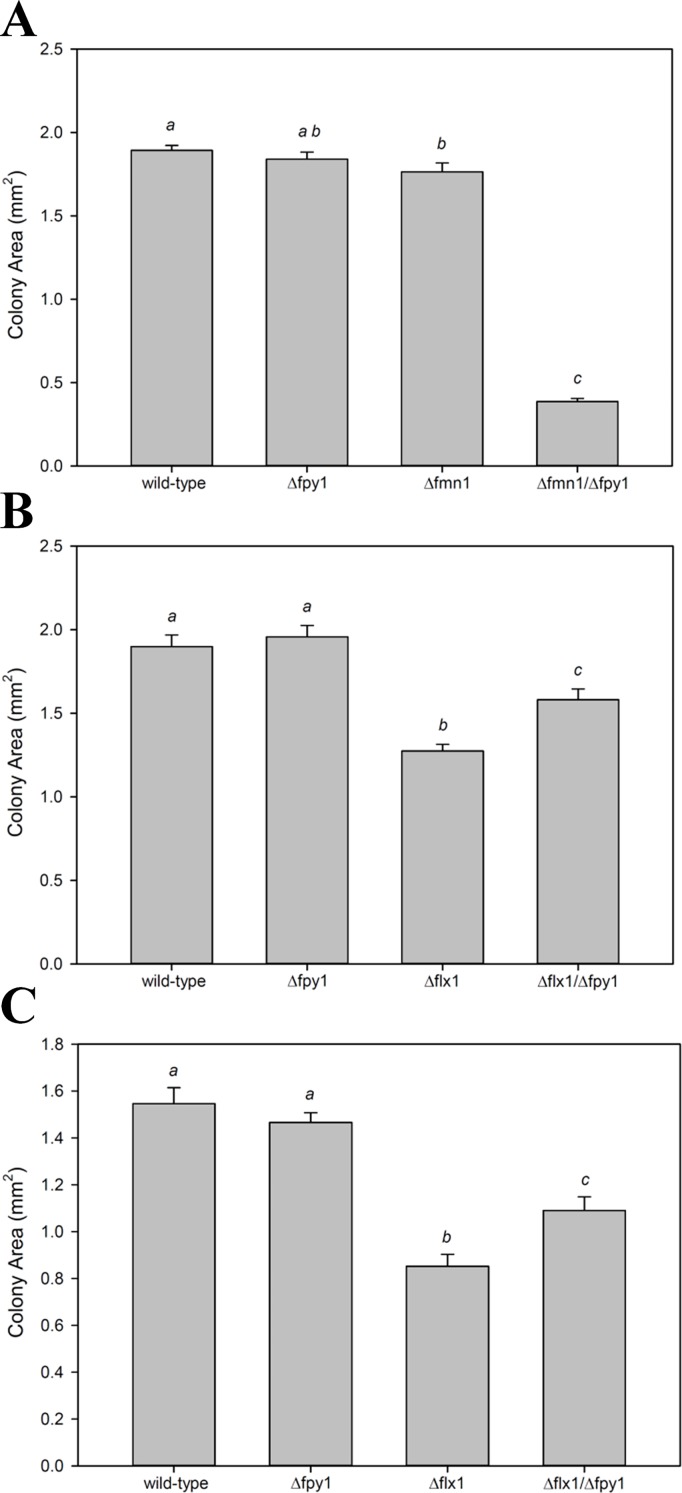
Growth analysis of wild type and mutant yeast under different conditions.(A) Colony size for wild type yeast and the Δfpy1, Δfmn1, and Δfmn1/Δfpy1 mutants grown on YPD supplemented with 4 mM FMN for 48 hours. (B) Wild type yeast and the Δfpy1, Δflx1, and Δflx1/Δfpy1 mutants grown on either SD/MSG medium for 72 hours or (C) YPD medium for 48 hours. Colony size was measured as described in Experimental Procedures. Data are given as the average ± S.E of 6–18 colonies per mutant line per condition tested. Different letters within each chart signify data which are statistically different (p < .05) based on one-way ANOVA with Holm-Šidák pairwise comparison.